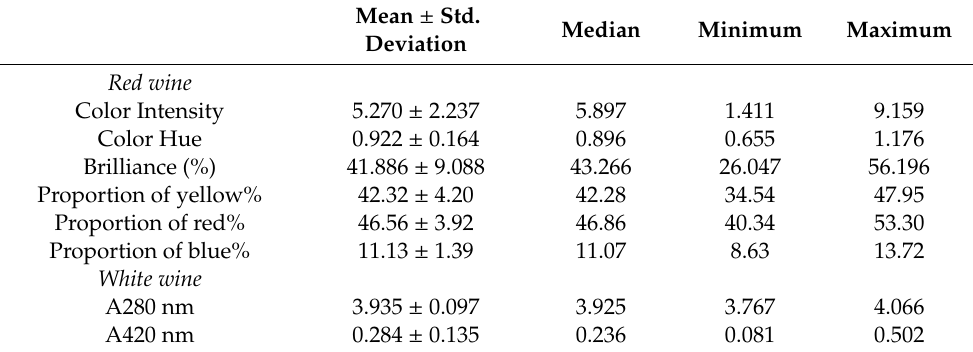
Table 3. Color variables among the wines produced by amateur winemakers of Drama region in Greece *. Mean ±